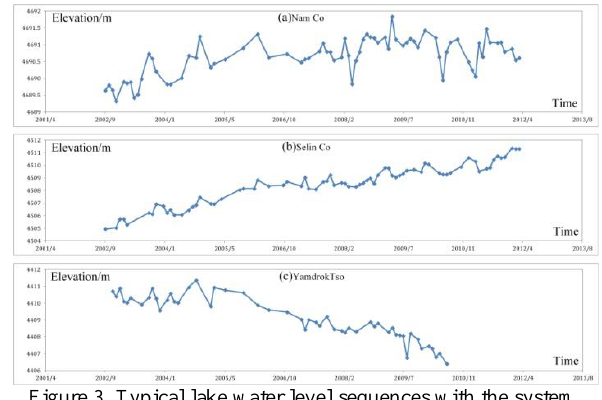
Figure 3. Typical lake water level sequences with the system errors removed (a) Nam Co; (b) Selin Co; (c) YamdrokTso.